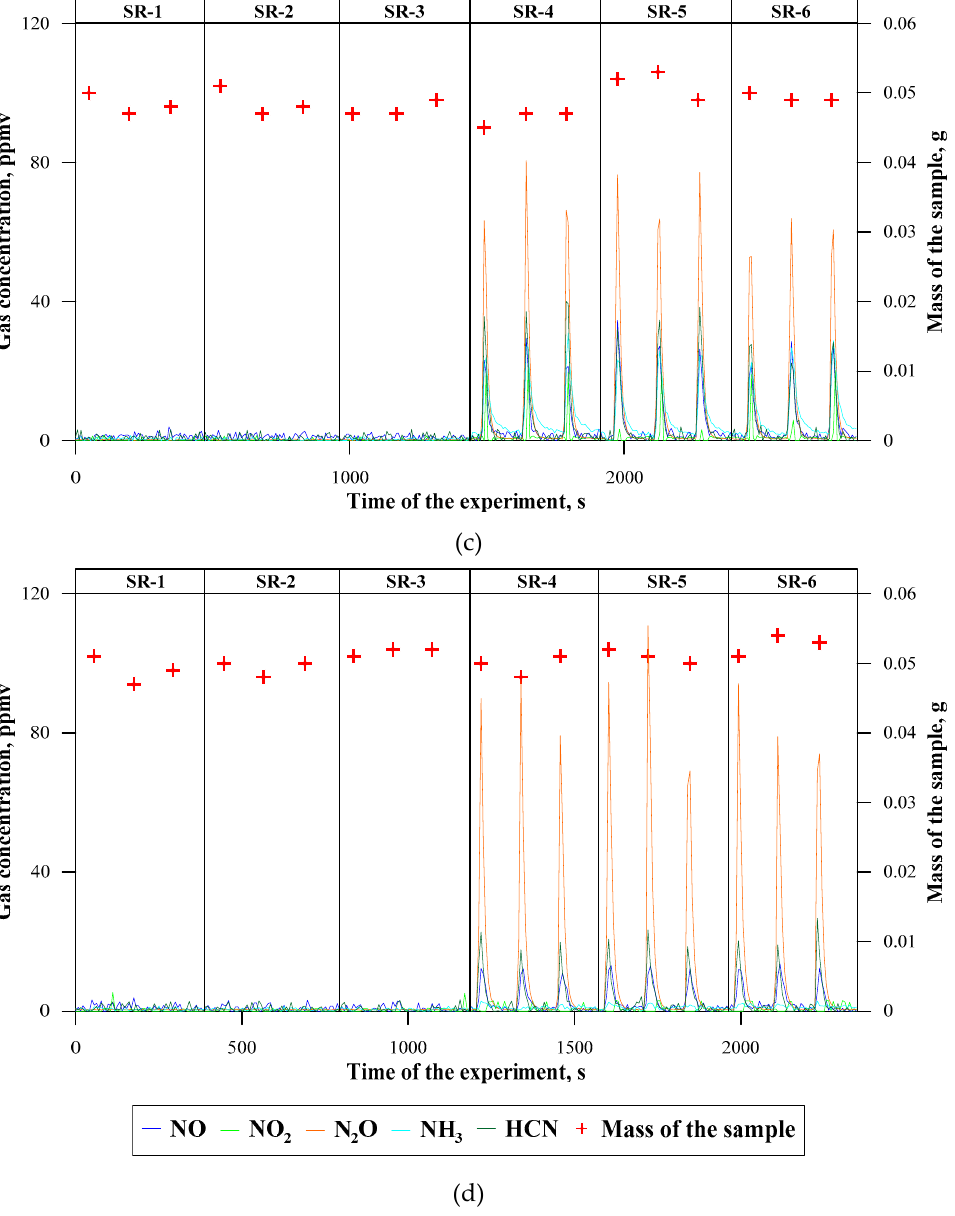
Figure 4. Concentrations of nitrogen compounds emitted during thermal decomposition of silicon rubber composites: ( a ) at 500 °C; ( b ) at 600 °C; ( c ) at 700 °C; and, ( d ) at 800 °C.